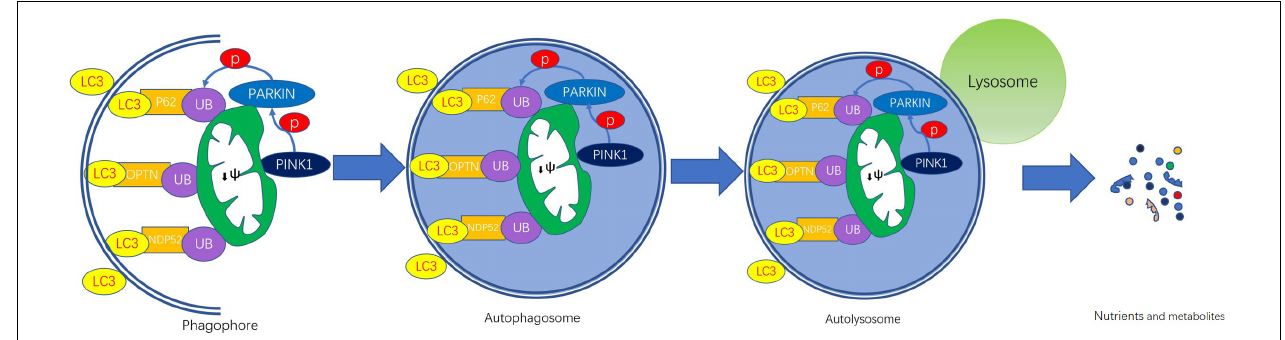
FIGURE 1 | PINK1/Parkin-mediated mitophagy. The steps of mitophagy include the formation of the phagophore, autophagosome, autolysosome, and degradation of mitochondria. Damaged mitochondria that have lost their membrane potential ( ψ m) leads to PINK1 accumulation on the outer membrane surface. Then PINK1 recruits cytosolic Parkin, thereby phosphorylating. Activated Parkin contributes to the hyper-ubiquitination of OMM proteins, which are recognized by ubiquitin-binding adaptors, such as p62, NBR1, OPTN, and NDP52. These adaptor proteins induce the formation of autophagosomes by binging to LC3. The fusion of autophagosome and lysosome forms autolysosome in which enzymes are released to digest the contents and the nutrients and metabolites are recycled.